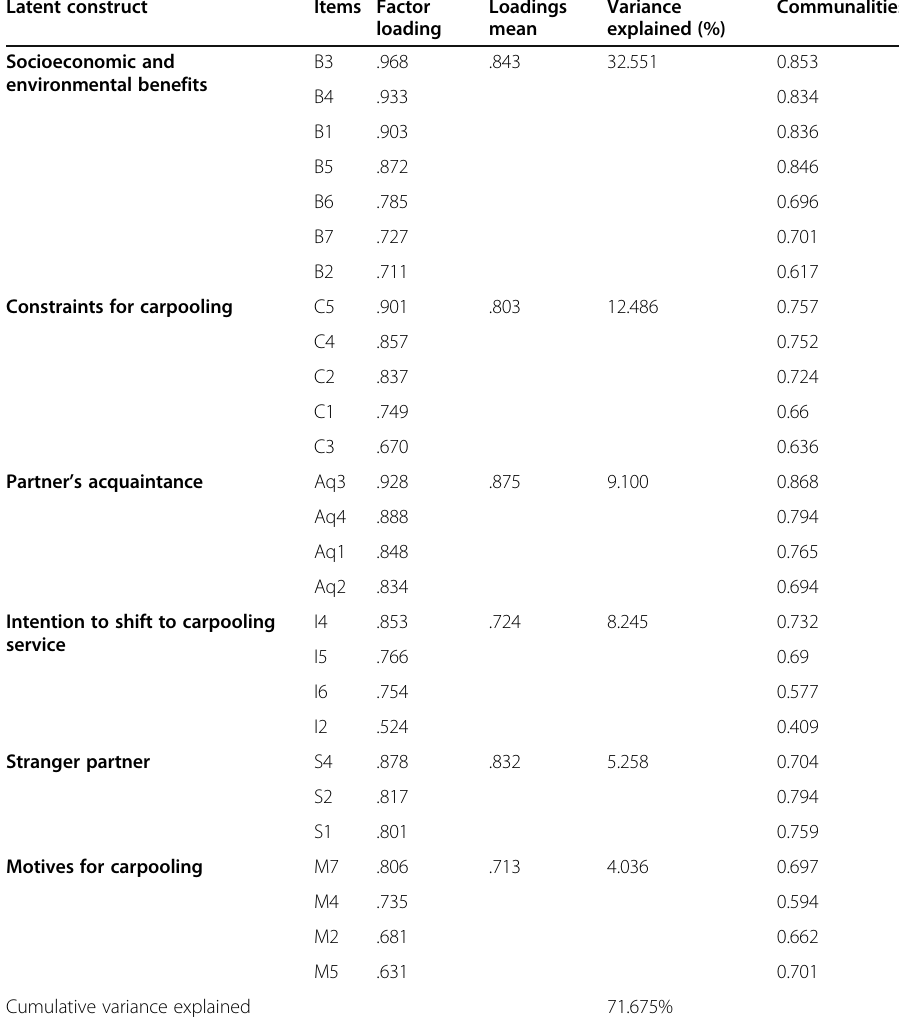
Table 5 PCA pattern matrix and exploratory factor analysis (EFA)